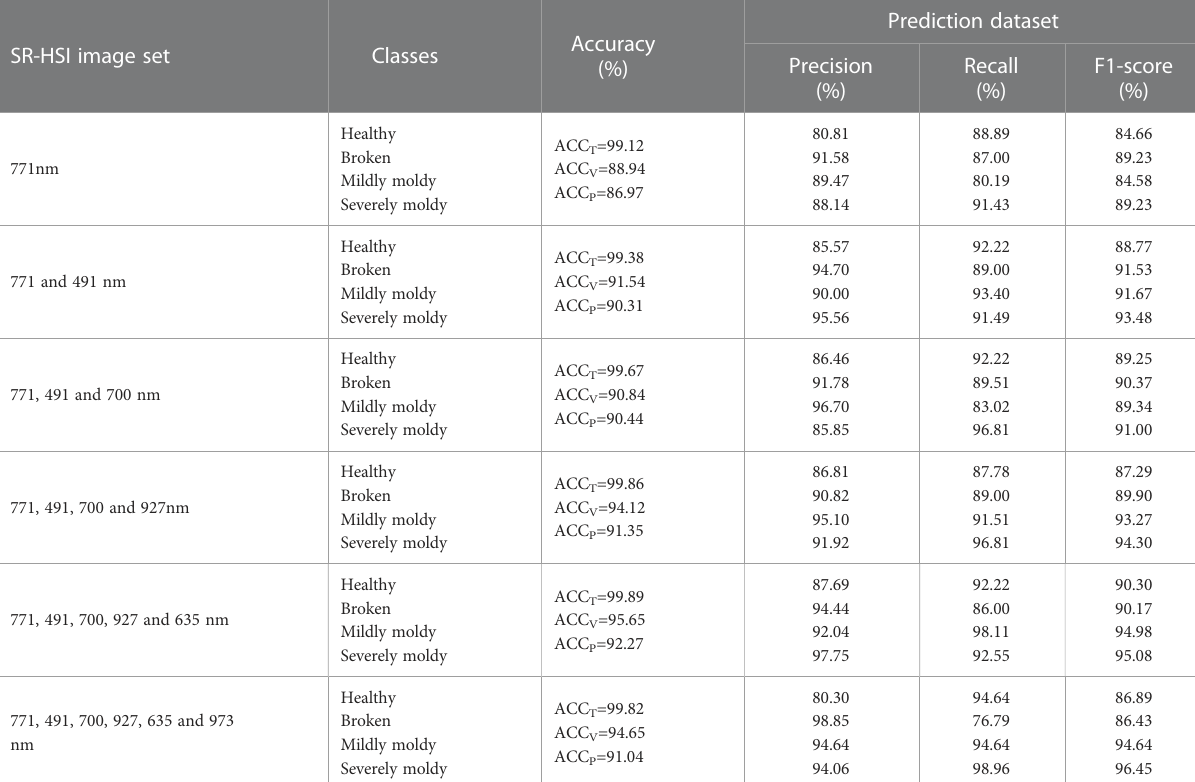
TABLE 2 Classi fi cation results of soybean kernels using Shuf fl eNet with SR-HSI images of different combinations of EWs.